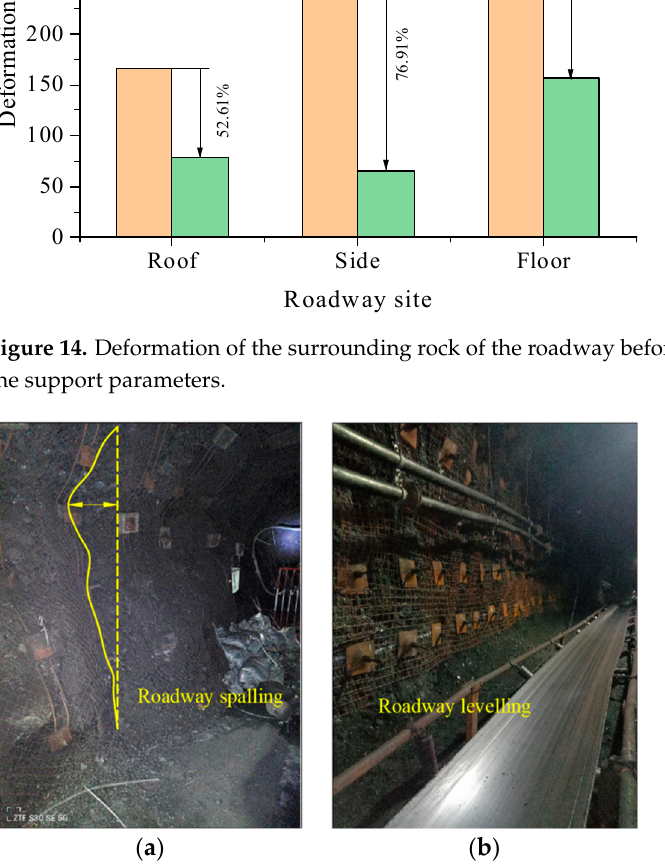
Figure 15. Control effect of the surrounding rock of the roadway before and after the optimization of the support parameters. ( a ) Before the optimization of the support parameters; ( b ) after the optimization of the support parameters.